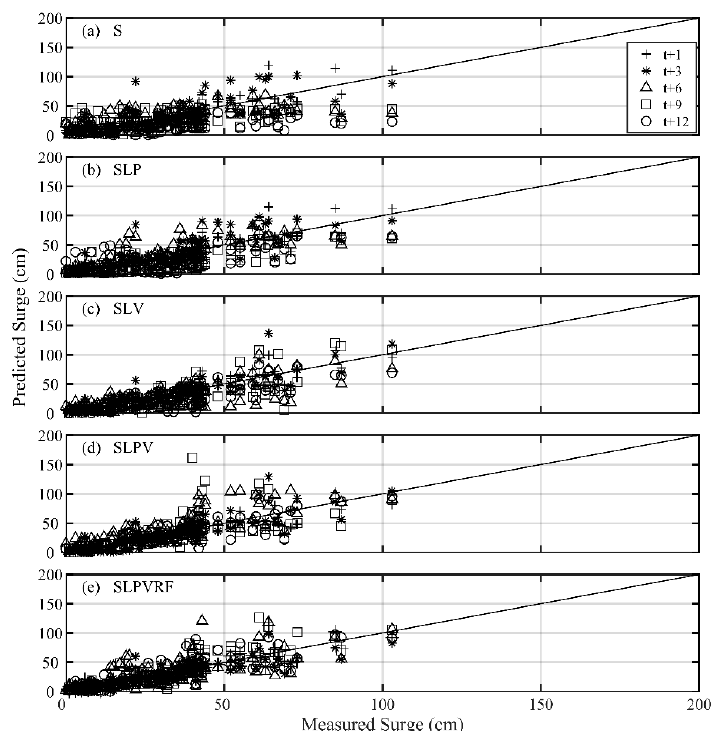
Figure 11. Scatter plots of predicted and measured storm surges for all validation events under different input combinations (from top to bottom panels) and lead-time (various symbols): ( a ) S , ( b ) SLP, ( c ) SLV, ( d ) SLPV, and ( e ) SLPVRF. Water 2020 , 12 , x FOR PEER REVIEW